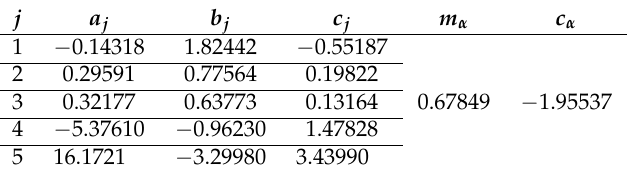
Table A5. Coefficients for α H .